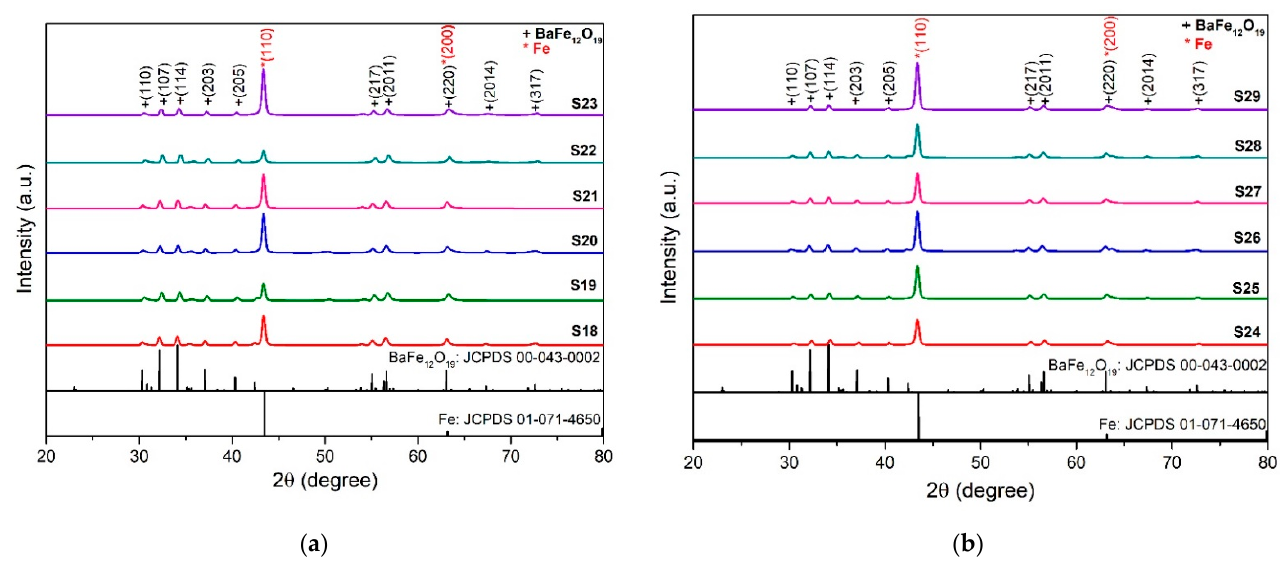
Figure 4. XRD spectra of samples ( a ) S18-S23 and ( b ) S24-S29.